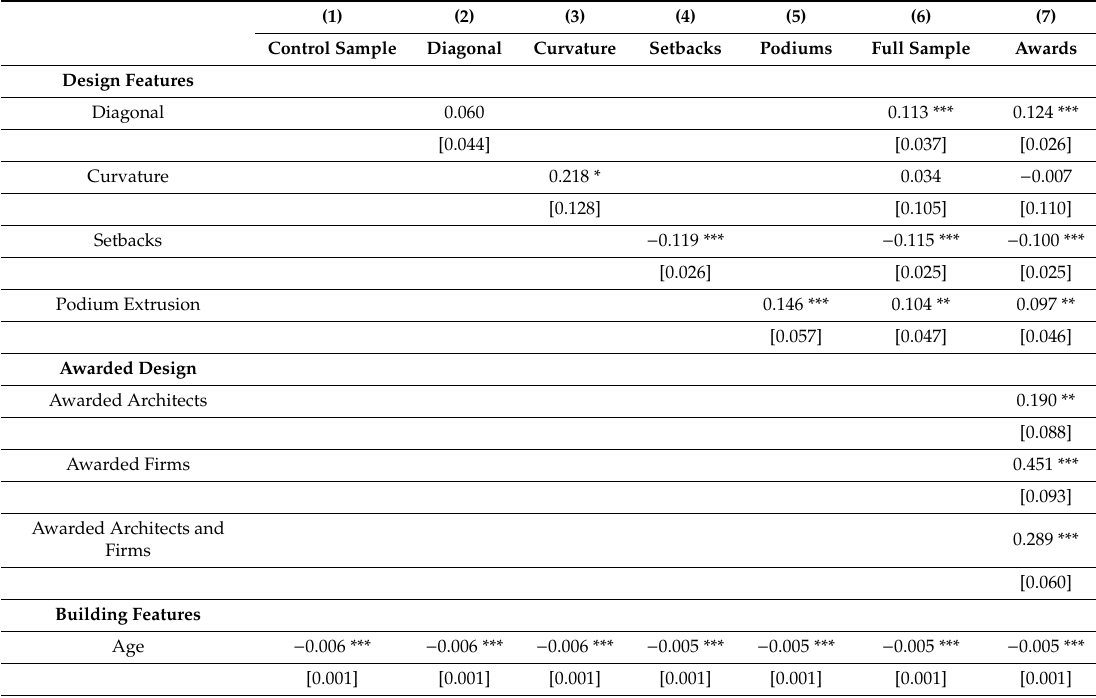
Table 2. Transaction prices of buildings with architectural design features with dependent variable: Logarithm of transaction price. Column one: Base model with control sample (with none of the design features). Column two: Added diagonal intersection. Column three: Added curvature. Column four: Added setbacks. Columns five: Added podium. Column six: Added full sample (with all design features) and column seven: Full sample with the impact of awarded